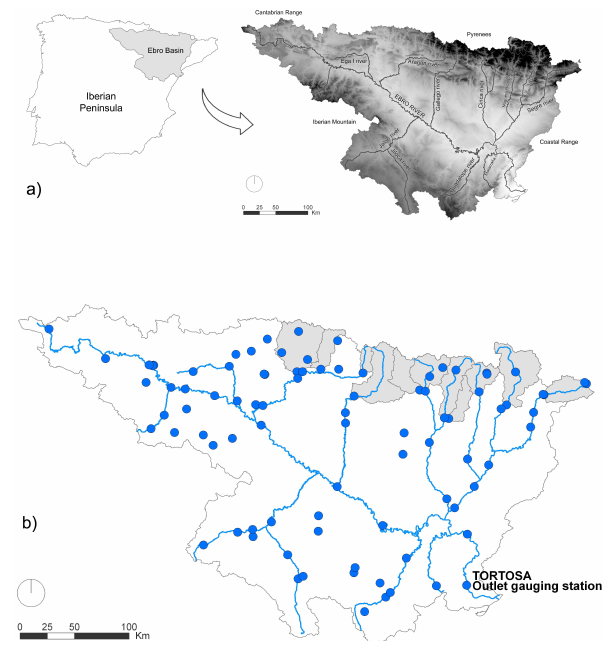
Fig. 1. Study area. (a) relief of the Ebro River basins and main tributaries of the Ebro River. (b) Gauging station network, and areas included as Pyrenean headwaters (in grey